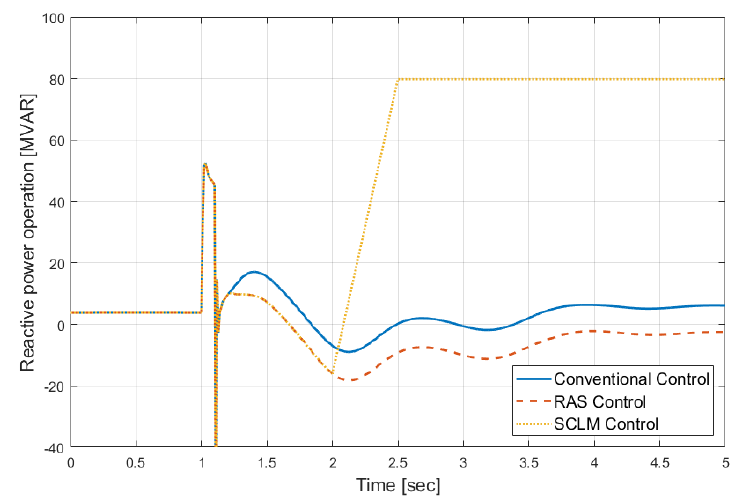
Figure 14. Reactive power operation change in the line overload case at the inverter end.